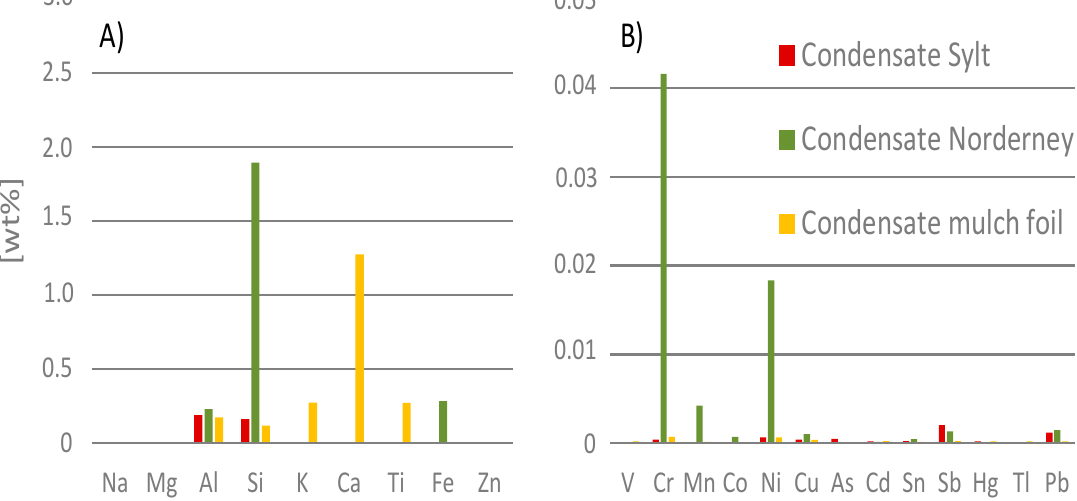
Figure 11. Mass fraction of selected elements in pyrolysis condensate determined by XRF (n = 2). ( A ) shows detected elements with the highest mass fractions. ( B ) shows heavy metals mentioned in the German ordinance for waste incineration (17. BImSchV).